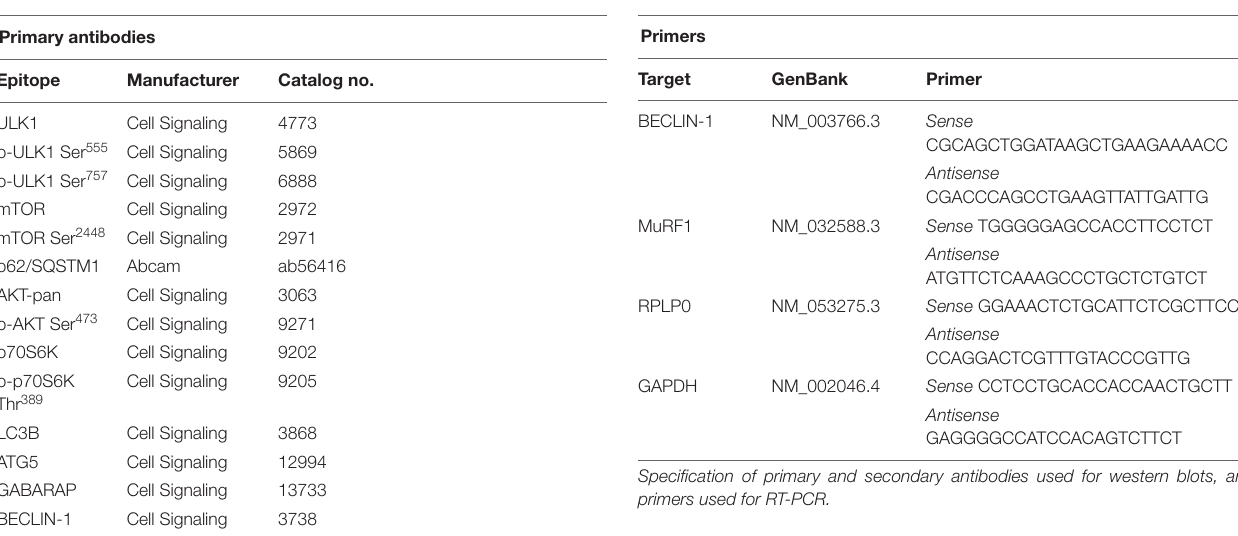
TABLE 1 | Antibody and primer